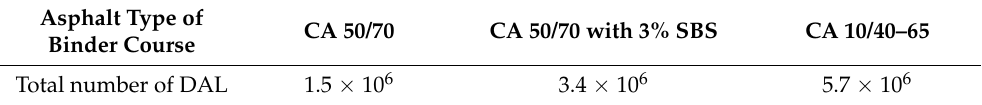
Table 4. Total number of